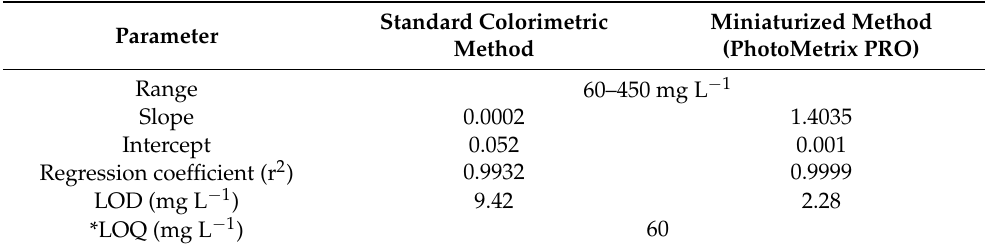
Table 1. Regression and validation parameters for the standard colorimetric method and the Pho- toMetrix PRO method.